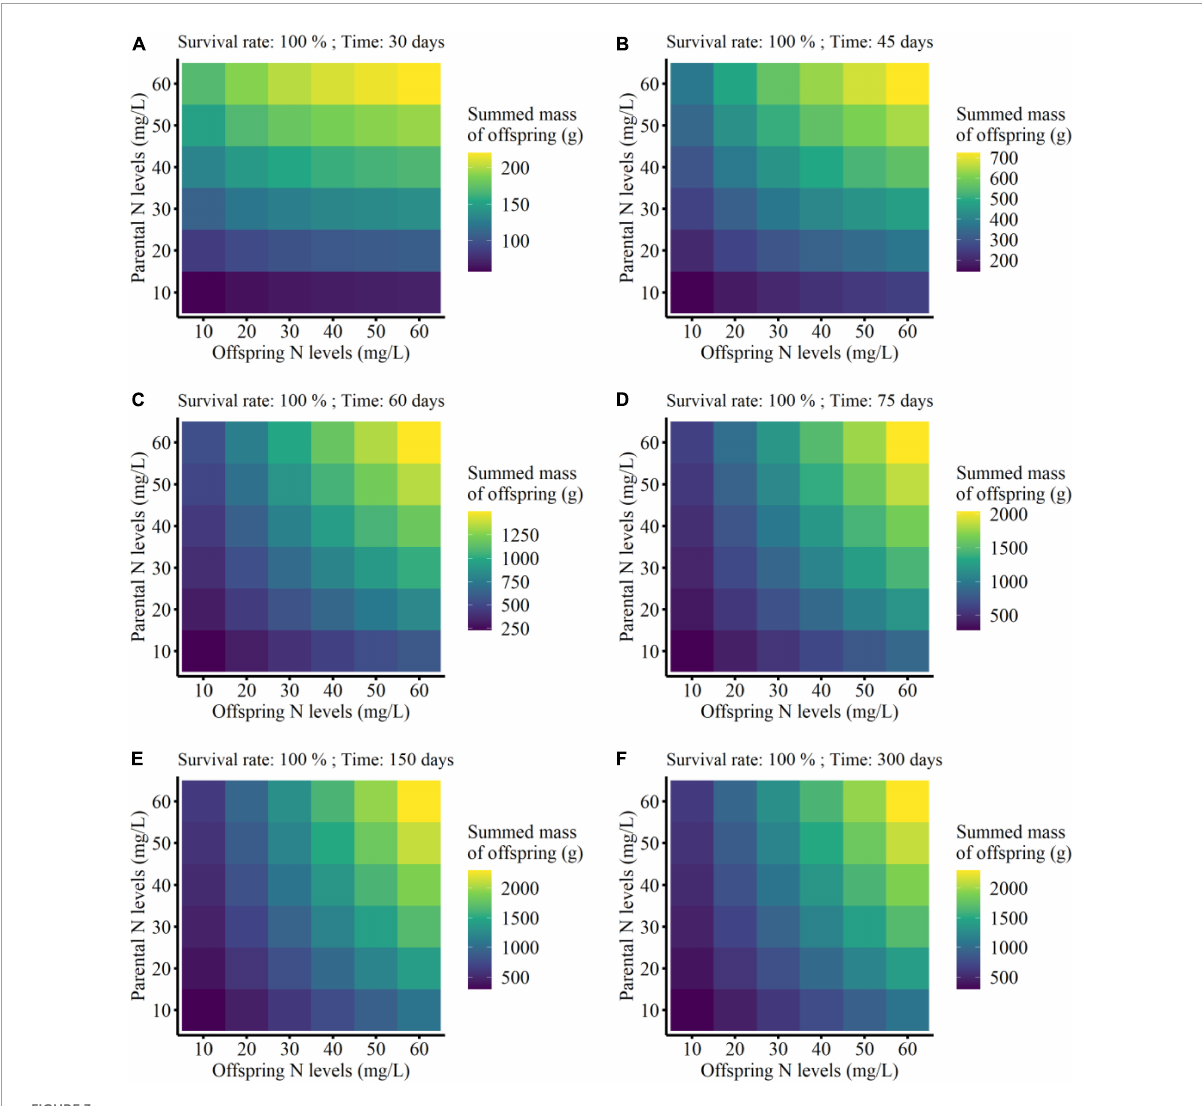
FIGURE3 Summed finial mass of the offspring grown from the surviving clonal propagules produced by each parental plant at the different developmental time (from 30 to 300 days; A–F ) in the simulation experiment. The summed performance of clonal offspring with 100% survival rate were shown